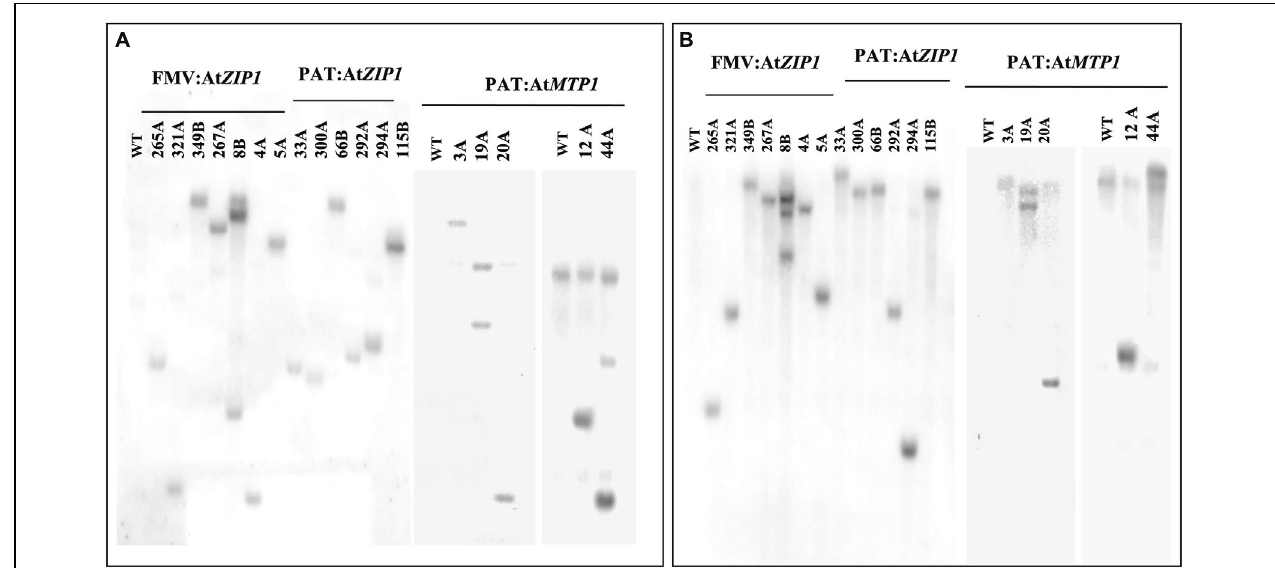
FIGURE 2 | Copy number determination using Southern blot hybridization of genomic DNA samples isolated from leaves of wild type and transgenic lines disgested with HindIII (A) and BamHI (B). WT, wild type.